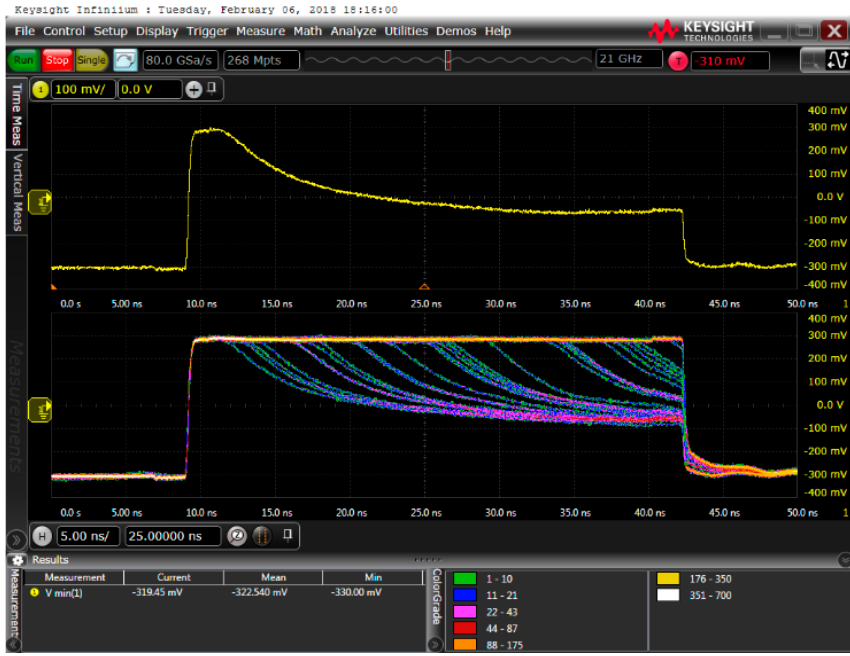
Figure 5. Oscilloscope picture of one avalanche ( top ) and several overlaid avalanches ( bottom ) of the cathode voltage of a SPAD type B with 48.2 µm diameter for an illumination power with a halogen source to achieve somewhat equally distributed photon hits.